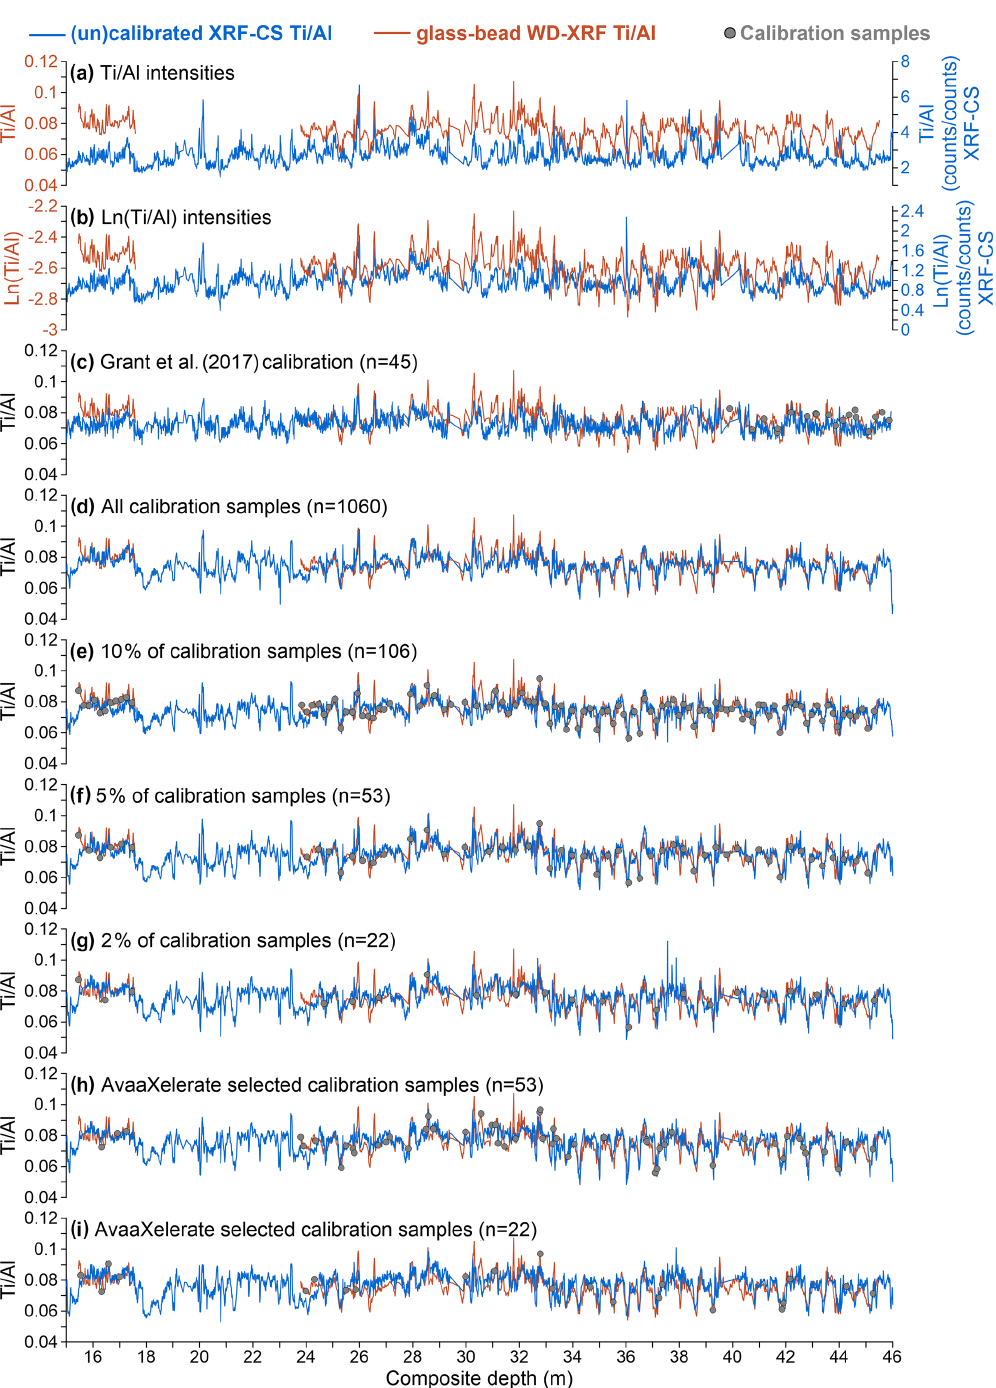
Figure 2. Uncalibrated and calibrated Ti / Al ratios (blue) for different XRF-CS calibration strategies versus reference values obtained using glass-bead WD-XRF (orange; Konijnendijk et al., 2014a, 2015). (a) Ti / Al from XRF-CS intensities. (b) Ln(Ti / Al) from XRF-CS intensities. (c) Ti / Al using the calibration of Grant et al. (2017). (d) Ti / Al using all 1060 calibration samples from glass-bead WD-XRF (Konijnendijk et al., 2014a, 2015). (e) Ti / Al using 10% of the samples from glass-bead WD-XRF. (f) Ti / Al using 5% of the samples from glass-bead WD- XRF. (g) Ti / Al using 2% of the samples from glass-bead WD-XRF. (h) Ti / Al using the 53 samples selected by AvaaXelerate (Bloemsma, 2015). (i) Ti / Al using the 22 samples selected by AvaaXelerate (Bloemsma, 2015). Gray circles represent data points used as calibration samples. Two high-Ti / Al data points (0.13–0.14) were omitted from the glass-bead WD-XRF record at 26m for clarity but are incorporated in the statistical calculations. Statistical test results associated with these data are presented in Table